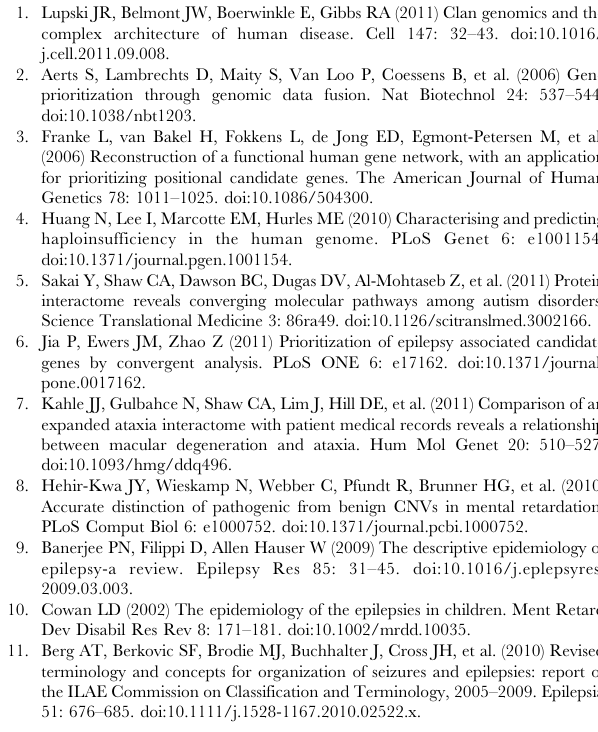
Table S1 Epilepsy training genes. Table S2 Pathogenicity scores, Bayes factors and posterior rate distribution parameters for each RefSeq gene. Table S3 Cut-off values for determining enrichment in each annotation scheme. Table S4 Included and excluded indications for the definition of a non-neurologic cohort. Table S5 Genes contributing to the maximum Bayes factor analysis in each analysis cohort